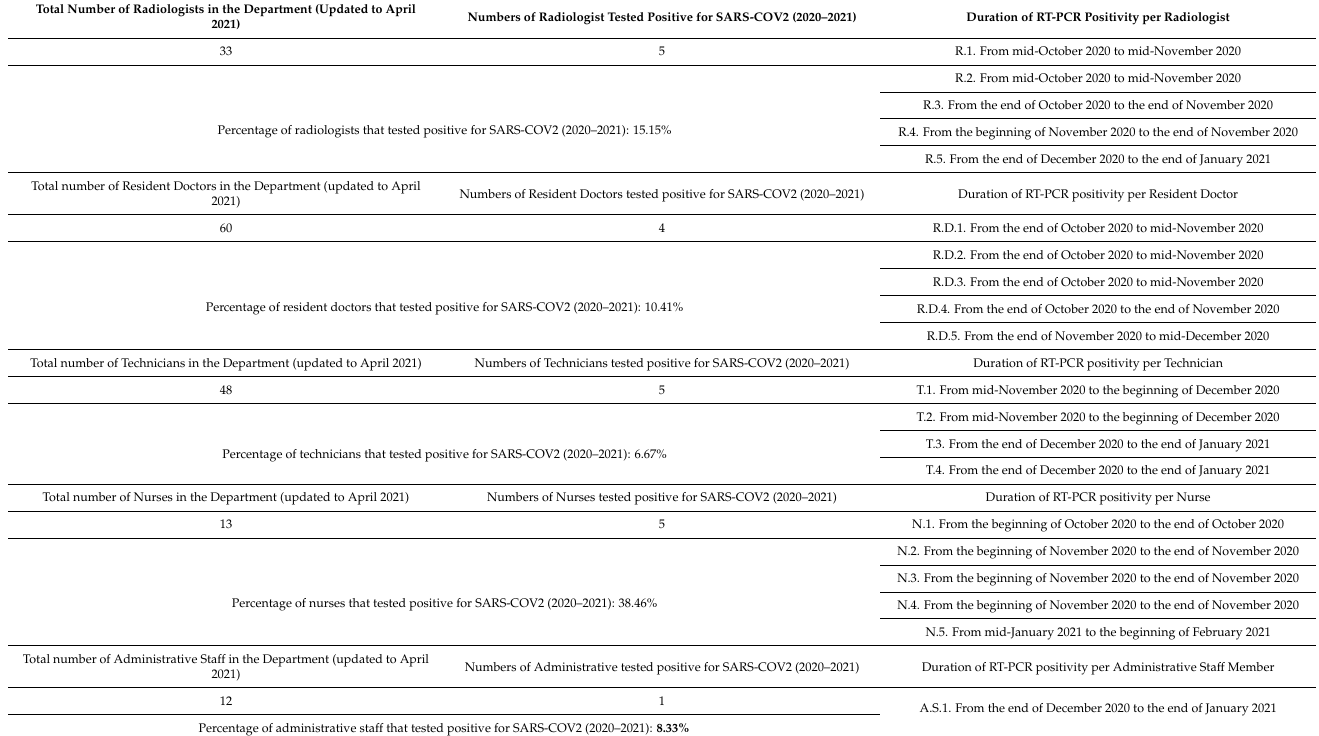
Table 1. Staff members of the Radiology Department of the “Policlicnico Tor Vergata” Hospital who tested positive for